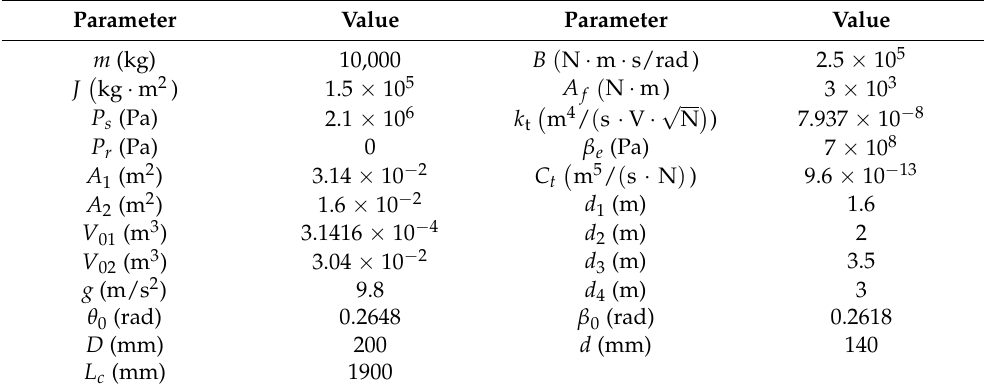
Table 1. Physical parameters of the EHA